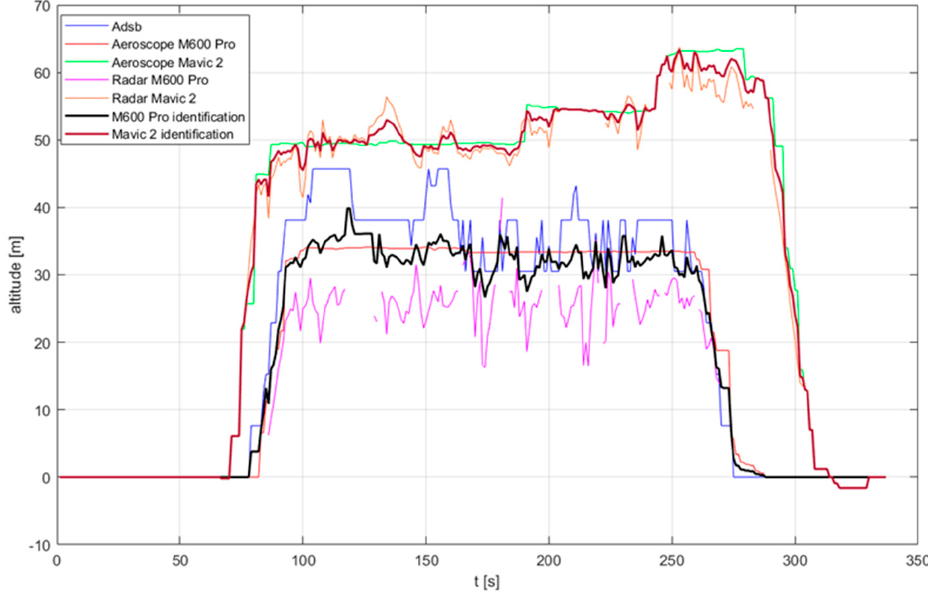
Figure 12. Multiple UAV flight altitudes–indirect detections and identifications.